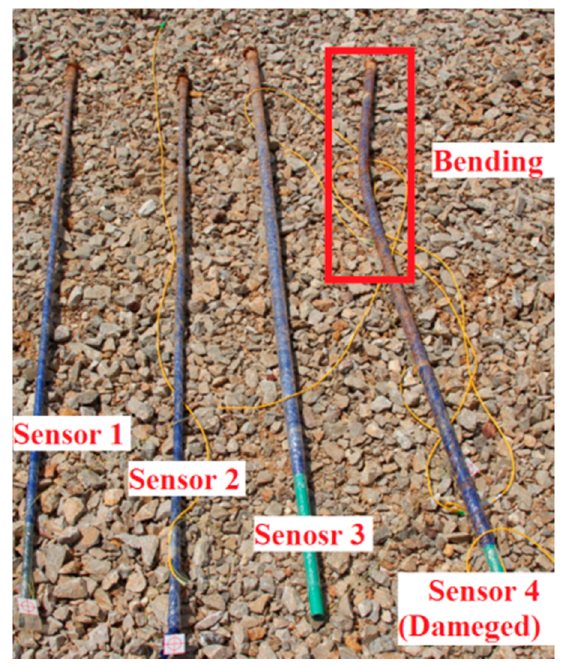
Figure 18. Sensors after the artificial landslide.